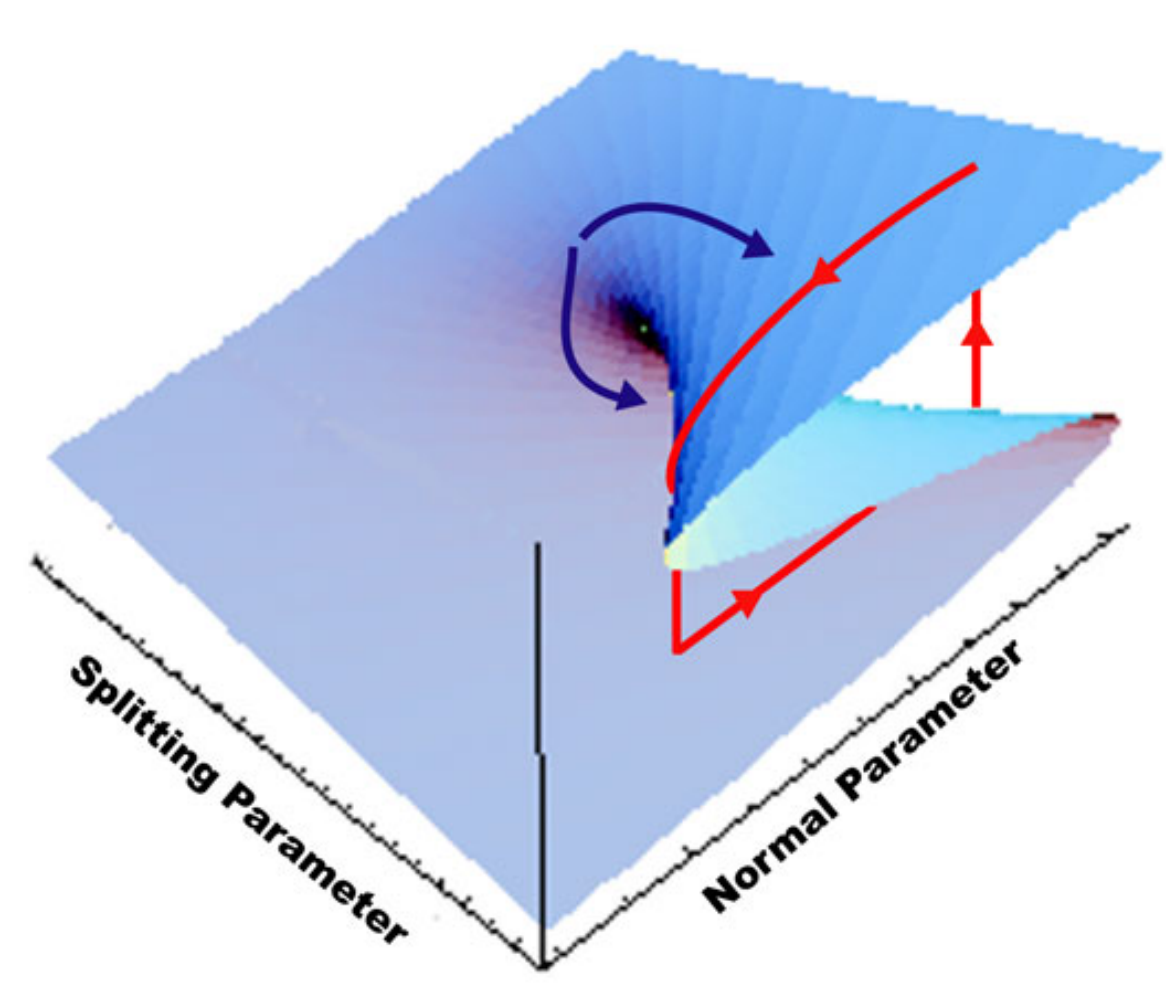
Fig. 2. The surface represents the equilibrium manifold of the cusp catastrophe. The path marked in red demonstrates the hysteresis, sudden jump and bimodality properties of the cusp. The blue paths represent the divergence